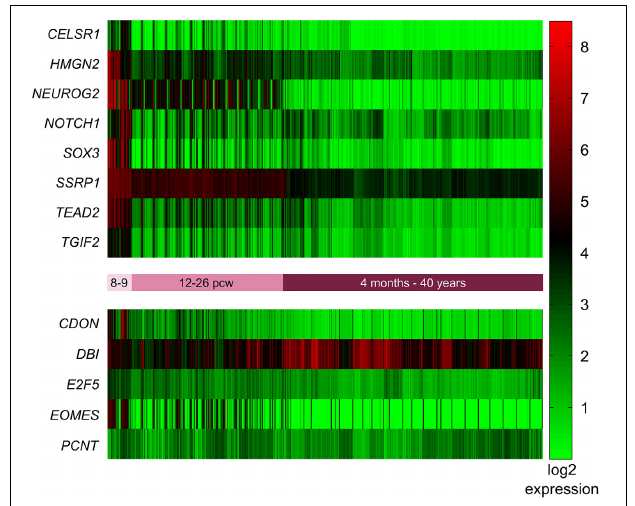
FIGURE 4 | Expression of mouse network genes in the human brain throughout development. Genes with significantly higher expression at post-conception weeks (pcw) 8–9 compared to later time points were analyzed using the developmental transcriptome dataset from the BrainSpan atlas of the developing human brain. Eight of the 13 mouse genes were significantly more highly expressed at 8–9 pcw: CELSR1 , HMGN2 , NEUROG2 , NOTCH1 , SOX3 , SSRP1 , TEAD2 , and TGIF2 . CDON , DBI , E2F5 , EOMES , and PCNT did not show increased expression during 8–9 pcw compared to later